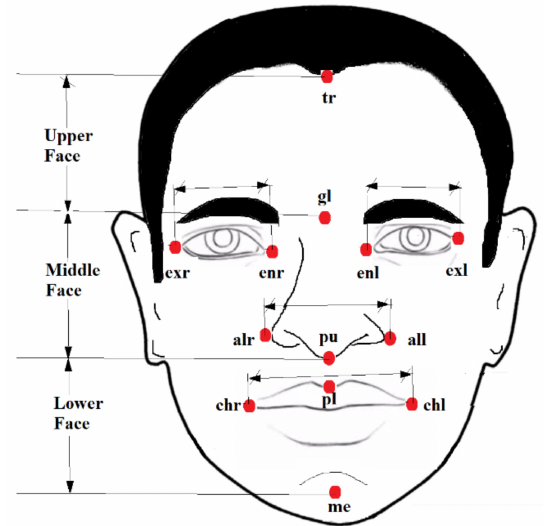
Figure 1. Anthropometric landmarks of frontal